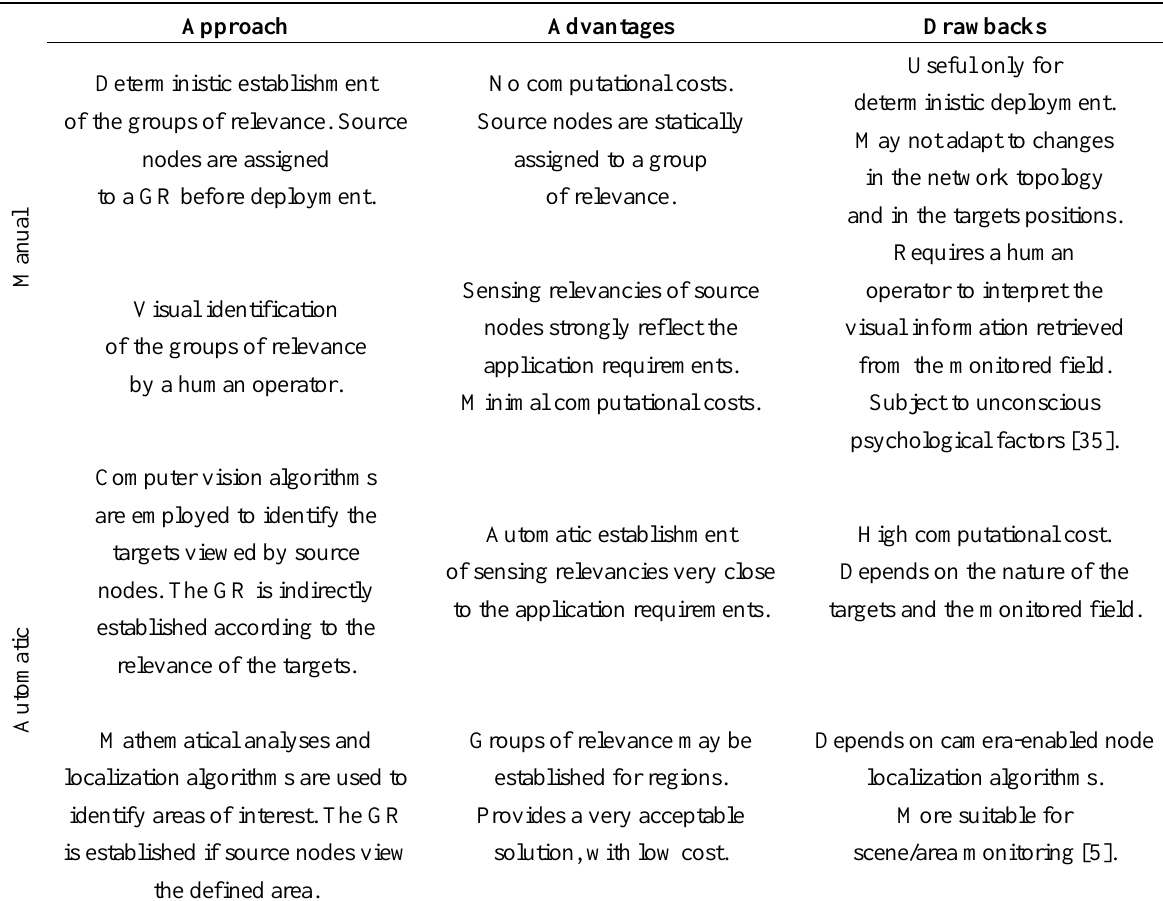
Table 2. Some approaches for computation of the groups of